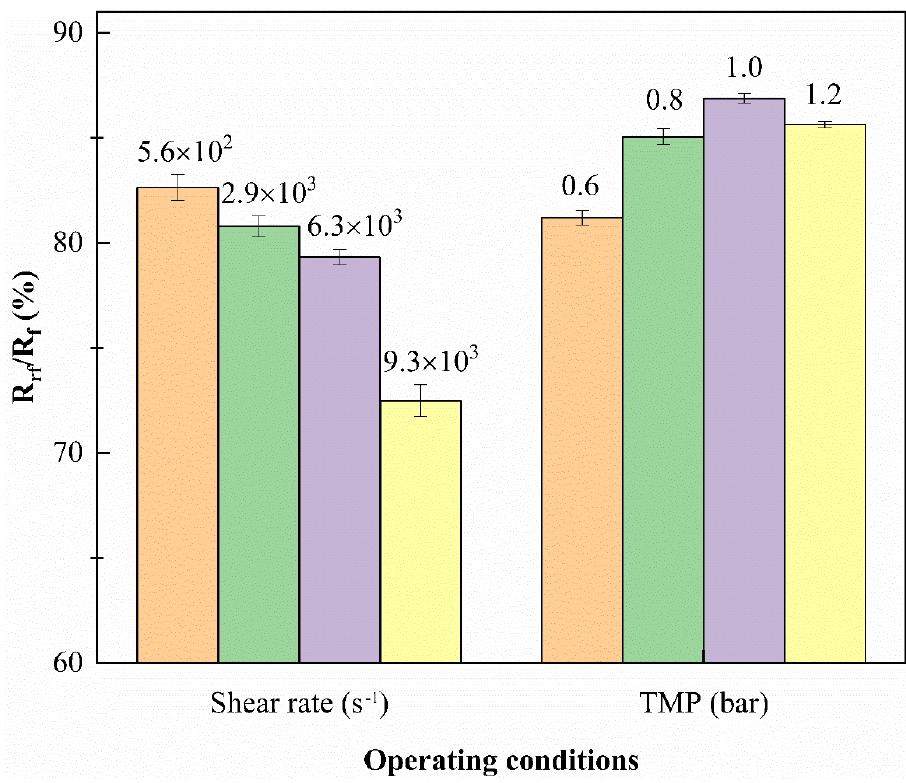
Membranes 2021 , 11 , x FOR PEER REVIEW 13 of 18 Figure 7. Percentage of the reversible fouling resistance ( 𝑅 𝑟𝑓 ) in total resistance ( 𝑅 𝑡 ). Figure 7. Percentage of the reversible fouling resistance ( R rf ) in in total resistance ( R t ). Table 4. Decomposition of fouling resistance in different operating conditions (PVDF 50 kDa).